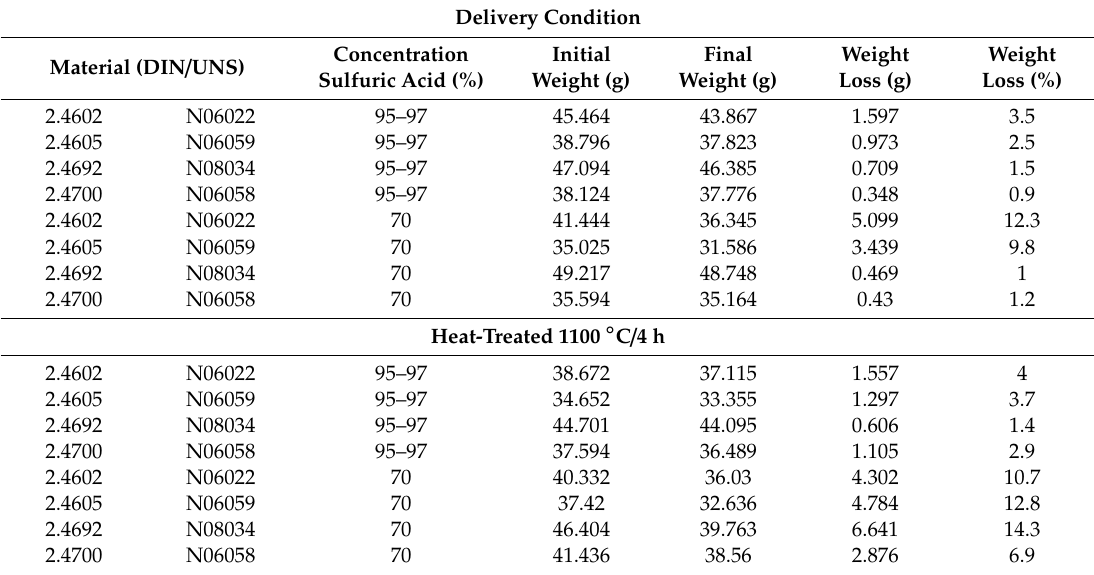
Table 1. Results of corrosion tests from [6] on four di ff erent materials aged in 70 and 95–97% sulfuric acid at 100 ◦ C for 1000